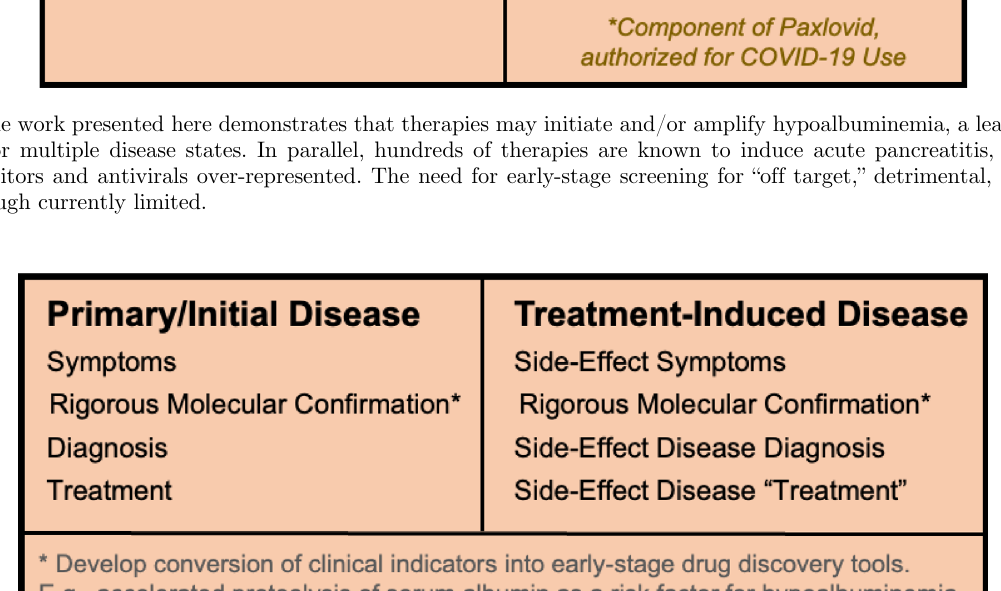
Figure 5. Given the growing potential for treatment-induced disease, side effects must be treated as potential symptoms for a second diagnosis. Rigorous, differentiating con fi rmation must be performed, diagnosis made and “ treatment ” applied, the latter being signi fi cantly complicated due to ongoing treatment for the primary or initial disease. Eliminating the likelihood of treatment-induced disease in early-stage drug discovery has enormous bene fi ts but can only become a reality if clinical indicators can be reliably converted into molecular risk factors for a speci fi c disease. Within a broad context, translation of clinical observations into the capacities of the research laboratory comprises a wholly new biomarker discovery